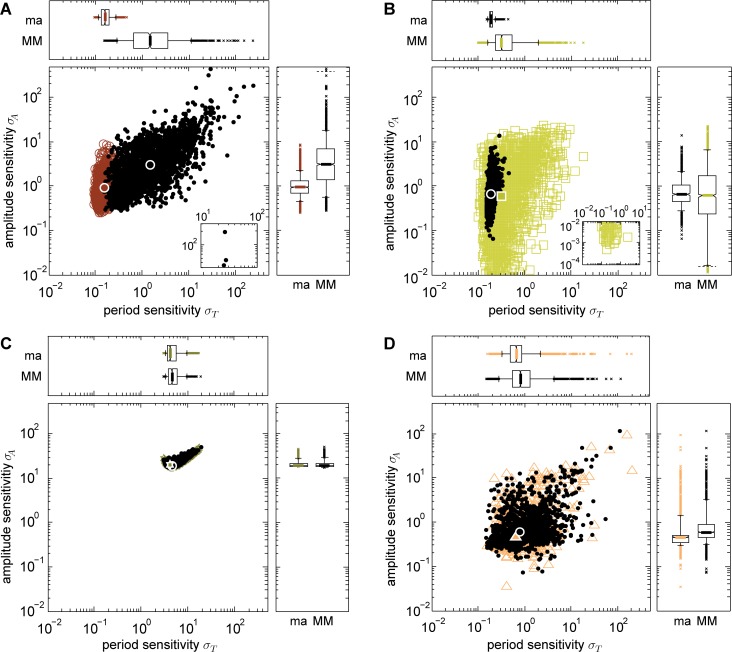
Sensitivities of models for various biological oscillations.A: Model of the repressilator [50] (brown circles). B: Model of the MAPK pathway [51] (yellow squares). C: Model of the glycolysis [52,53] (olive stars). D: Model of the cell cycle [54] (salmon triangles). White framed symbols denote median values. The schemes and further details of the models are given in S9 Fig. The originally published kinetics were altered employing Michaelis-Menten kinetics instead of mass action kinetics in A, C, D and mass action kinetics instead of Michaelis-Menten kinetics in B (black dots, black circle as median values). ma: mass action kinetics, MM: Michaelis-Menten kinetics.